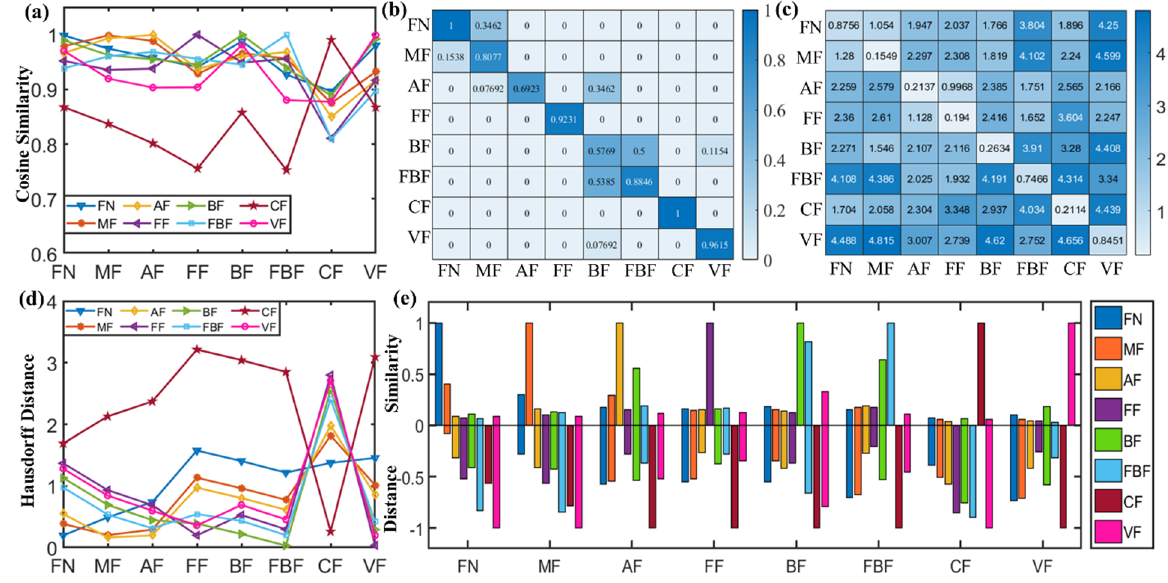
Figure 3. THz spectral similarity calculation for the eight fentanyl analogs based on ( a ) CS, ( b ) CCS, ( c ) DFD, ( d ) HD, and ( e ) the statistical histogram based on these four methods. Note: fentanyl, methoxyacetylfentanyl, acetylfentanyl, furanylfentanyl, butyrylfentanyl, 4-fluoroisobutyrfentanyl, carfentanil, and valerylfentanyl are abbreviated as FN, MF, AF, FF, BF, FBF, CF, and VF, respectively, in this figure.